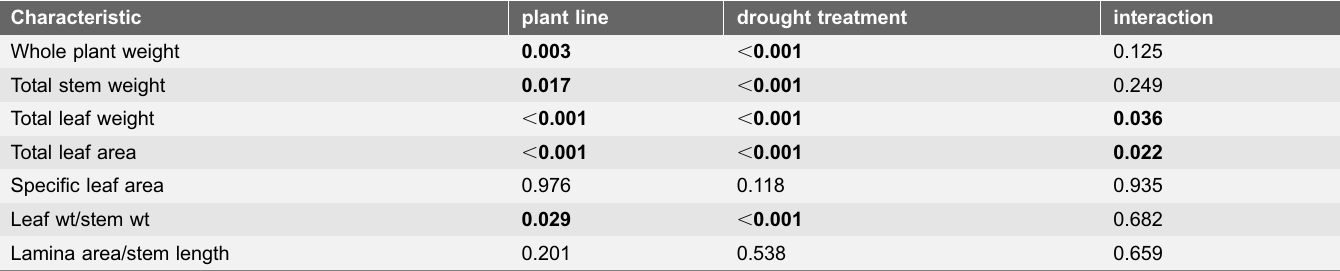
treatment (Table 4). Comparisons of RGR of control plants with mild-drought plants were not significant except for non-grafted 602 after the initiation of mild- drought treatment (Table 4). The differential effect of water treatment on growth before and after the mild-drought treatment is best represented by comparing daily weight gain to total plant length (Fig. 3). All plants had a linear increase in daily dry weight gain as stem length increased until a length of approximately 200 cm was reached. Mild-drought treated plant growth departed from their linear relationship with stem length before that of the control plants for all three plant-lines (Fig. 3). Maximum stem length attainable in the pots can be Table 3. Results for 2-way ANOVA performed on total plant weights and leaf area for three different lines of tomato experiencing either mild-drought or no- drought (control). Characteristic plant